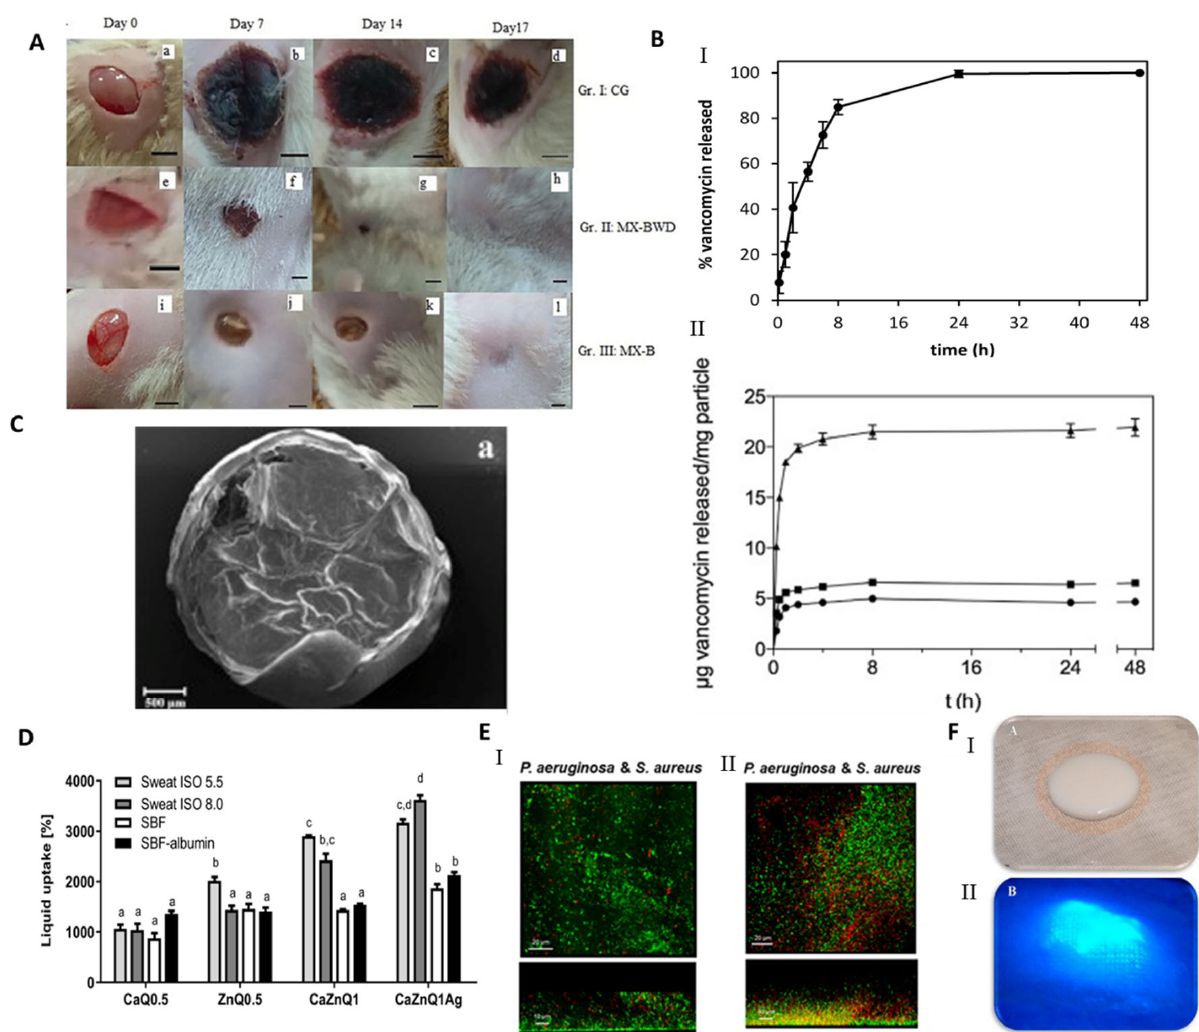
Figure 6. Use of bioaerogels in the treatment of wounds at the inflammatory stage: ( A ) In vivo wound healing (excision wound model) test in rat model consisting of five groups over a period of 17 days treatment. Group I: control (CG); Group II: moxifloxacin beads loaded in spongy wound dressing (MX-BWD) and Group III: moxifloxacin beads (MX-B). Adapted from ref [134], with permission from Elsevier. ( B ) Drug release of vancomycin from chitosan aerogels using sol–gel ( I ) jet cutting and ( II ) prilling methods. Reprinted from ref [81]. Reprinted from ref [73], with permission from Elsevier. ( C ) SEM image of core–shell alginate beads loaded with doxycycline showing the outer and inner structure of the beads. Reprinted from ref [21], with permission from Elsevier. ( D ) Liquid uptake quantification of alginate-based aerogels fluids incubated for 5 min in body fluid substitutes. Notation: CaQ0.5/ZnQ0.5 alginate aerogel with content of calcium/zinc. Alginate aerogel with content of calcium and zinc (CaZnQ1) and silver (CaZnQ1Ag). Reprinted from ref [135]. ( E ) LIVE/DEAD staining of 24 h dual-species biofilms grown in the presence of CNF aerogels. ( I ) Control of aerogels without OligoG ( II ) Oligo-bionanocomposites. Adapted from ref [71]. Copyright 2019 American Chemical Society. ( F ) pNA conjugate aerogels biosensor with protease activation with and without ultraviolet activation image ( I , II ): demonstrates the gauze contact layer and the aerogel biosensor layer with and without ultraviolet. Adapted from ref